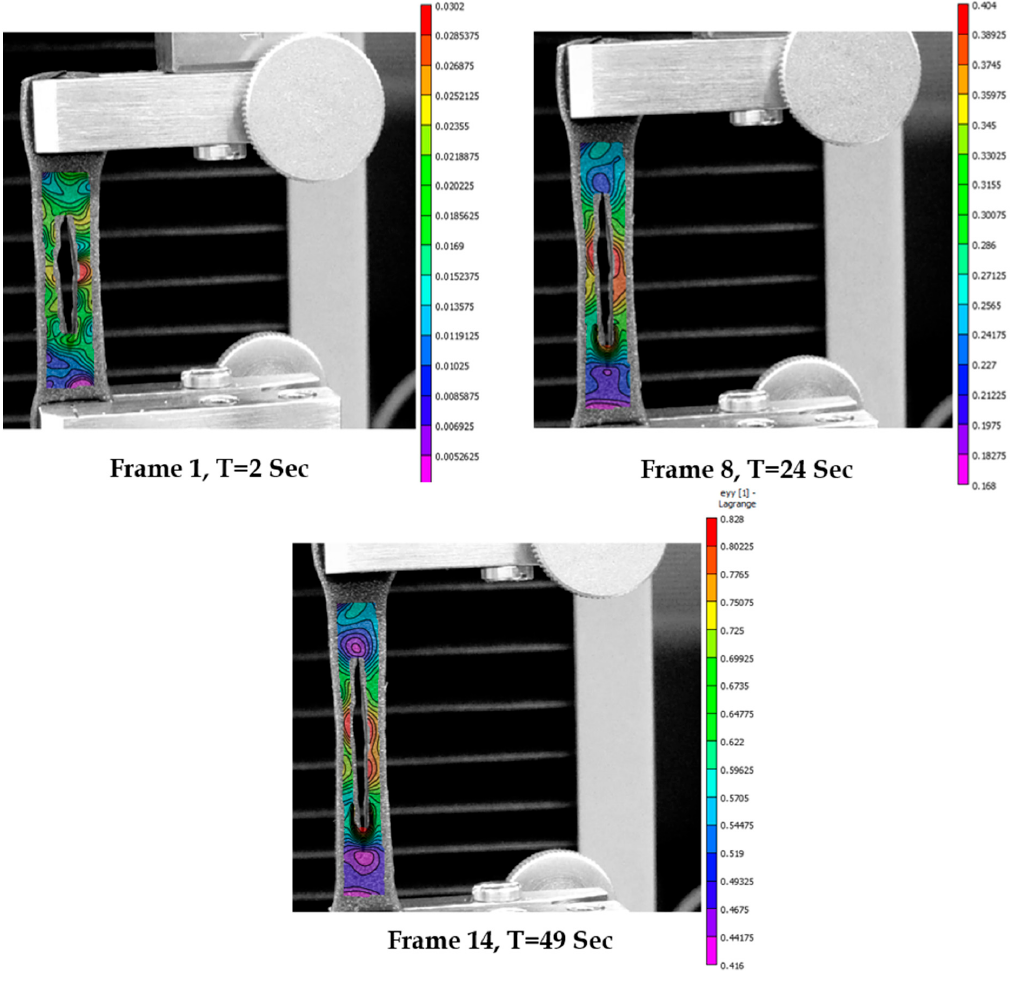
Figure 10. Strain distribution at different times for symmetric long wound 2 measured using DIC.